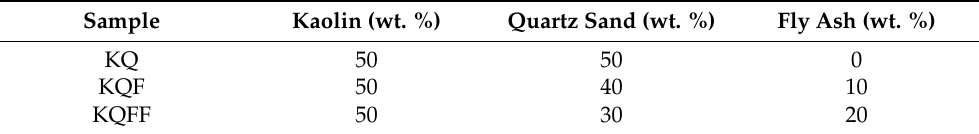
Table 3. The composition and indication of test